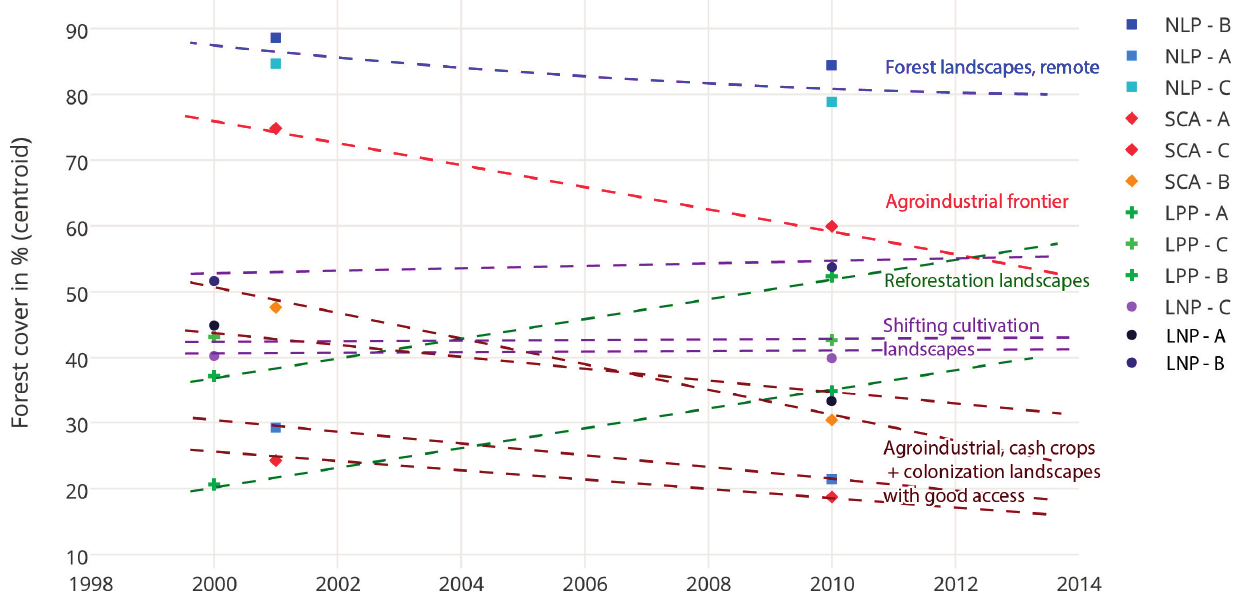
Figure 11. Social-ecological contexts and their possible outcomes in the four study